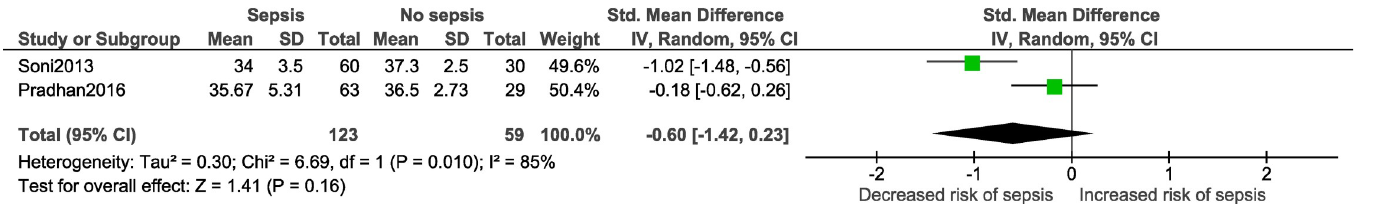
Fig 9. Forest plot showing a random-effects meta-analysis of gestational age of mothers of neonates with and without sepsis.